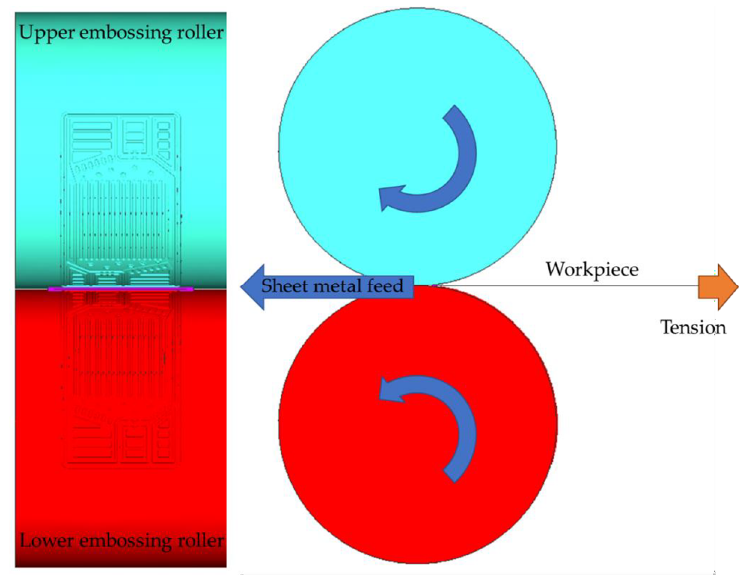
Figure 4. Simulation model view with component movement.